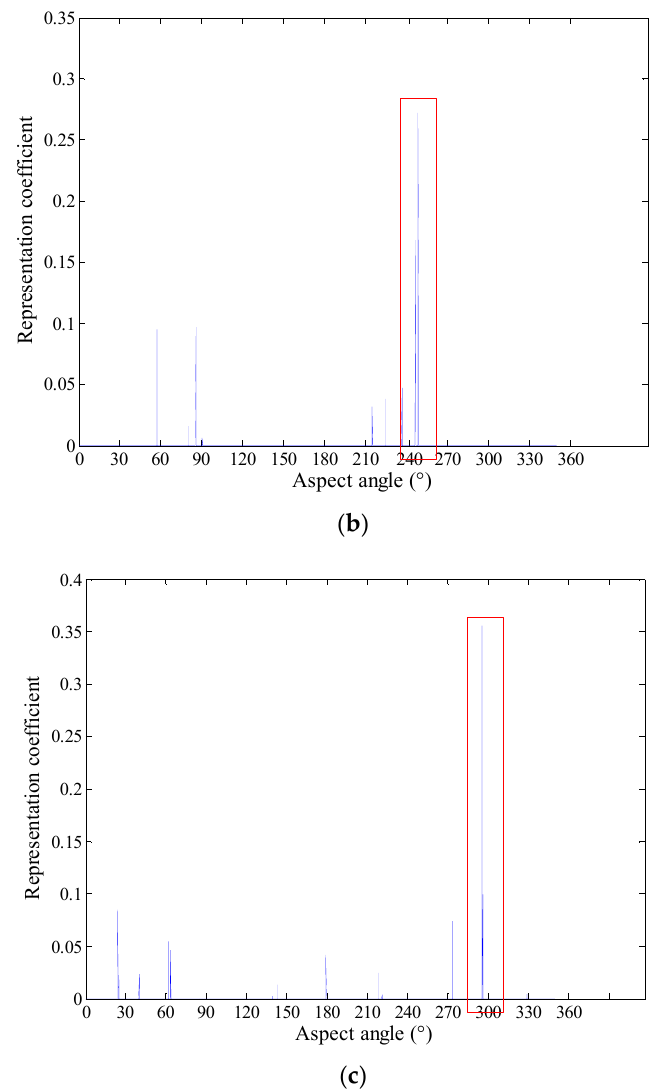
Figure 4. ( a ) The representation coefficient of Target1 (68.5 ° ). ( b ) The representation coefficient of Target2 (240.0 ° ). ( c ) The representation coefficient of Target3 (293.8 ° ).